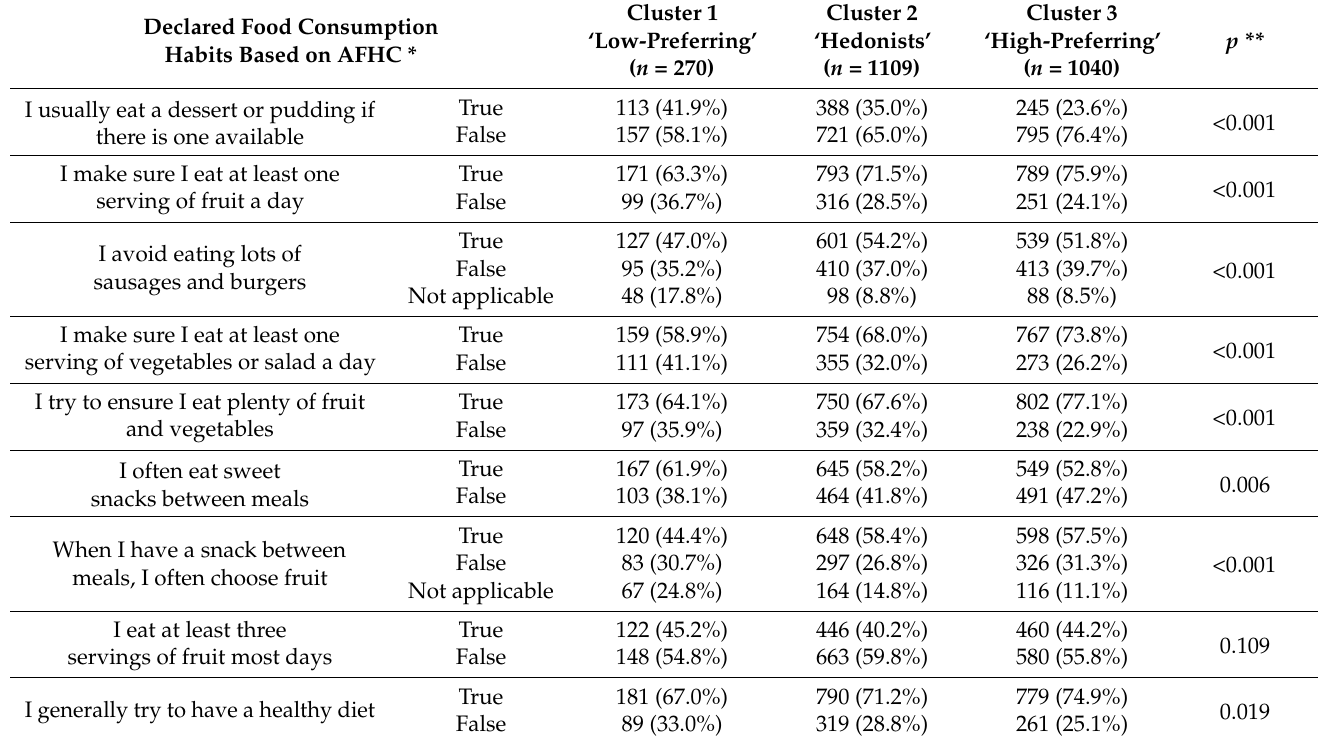
Table 5. The declared food consumption habits assessed based on the Adolescents’ Food Habits Checklist (AFHC) in the clusters stratified based on the preferences assessed while using Food Preference Questionnaire (FPQ) within the population of the second phase of the Polish Adolescents’ COVID-19 Experience (PLACE-19) Study ( n = 2419).